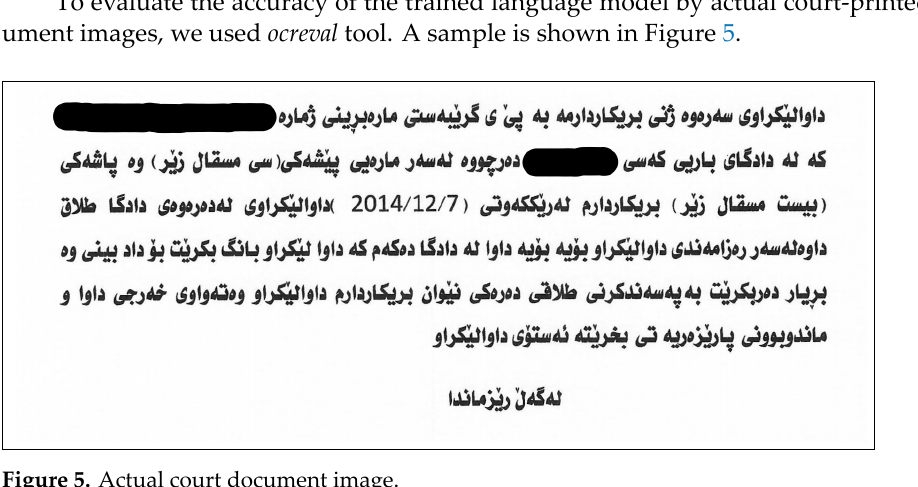
Figure 5. Actual court document image.